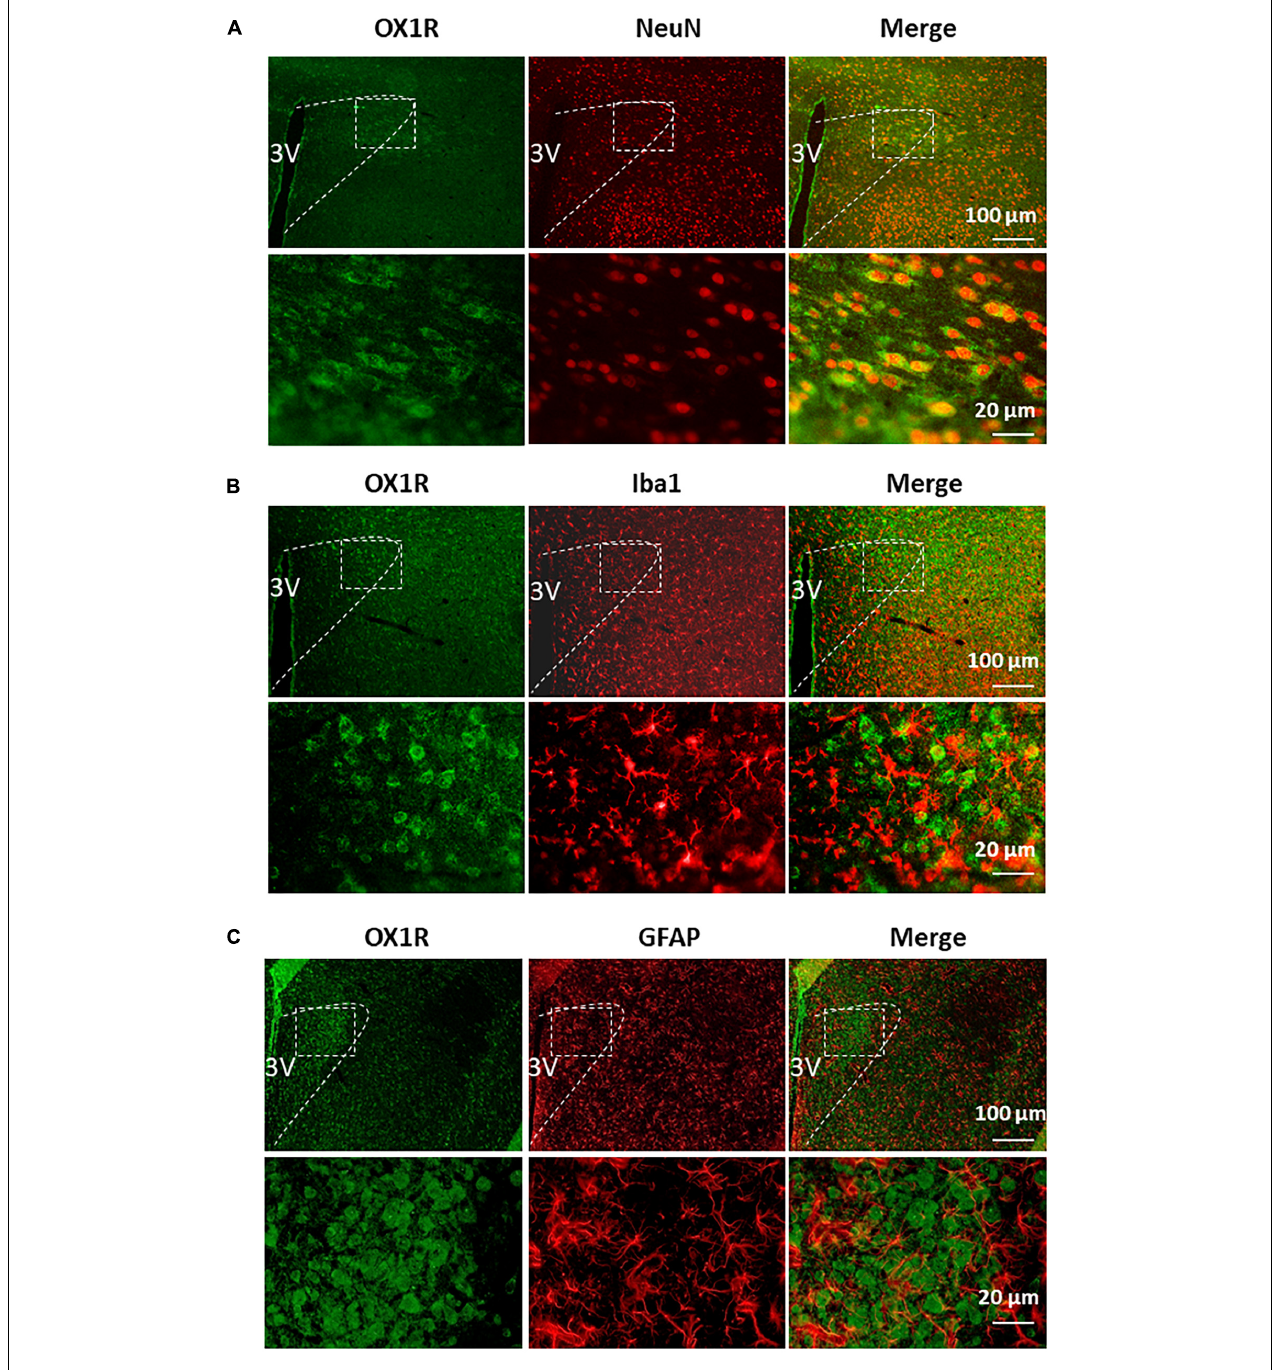
FIGURE 2 | PVN OX1R is primarily expressed in neurons in the SD rats. Representative images showing immunoreactivity of OX1R (green), neuronal nuclei NeuN [red (A) ], microglial marker Iba1 [red (B) ], astrocyte marker GFAP [red (C) ], and merged images in the PVN of SD rat. The area labeled in the dashed rectangle in the upper panel was magnified and showed in the lower panel. The brain coronal sections were taken from 1.8 mm caudal from the bregma. 3V, the third ventricle.